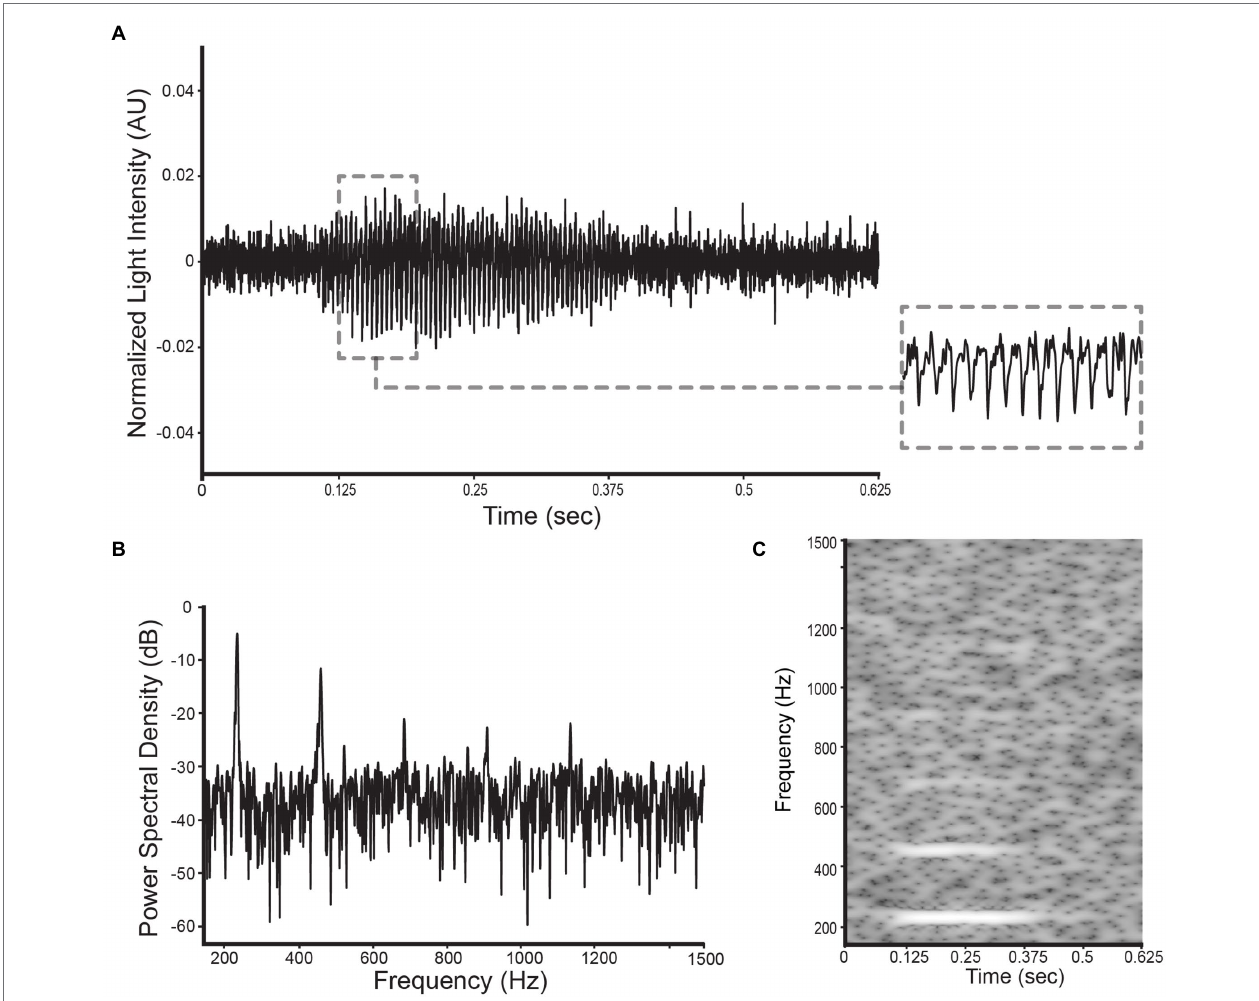
FIGURE 5 | Illustration of the selected datatypes used in this study for a D. suzukii signal: (A) the wingbeat signal, (B) its power spectral density, and (C) its